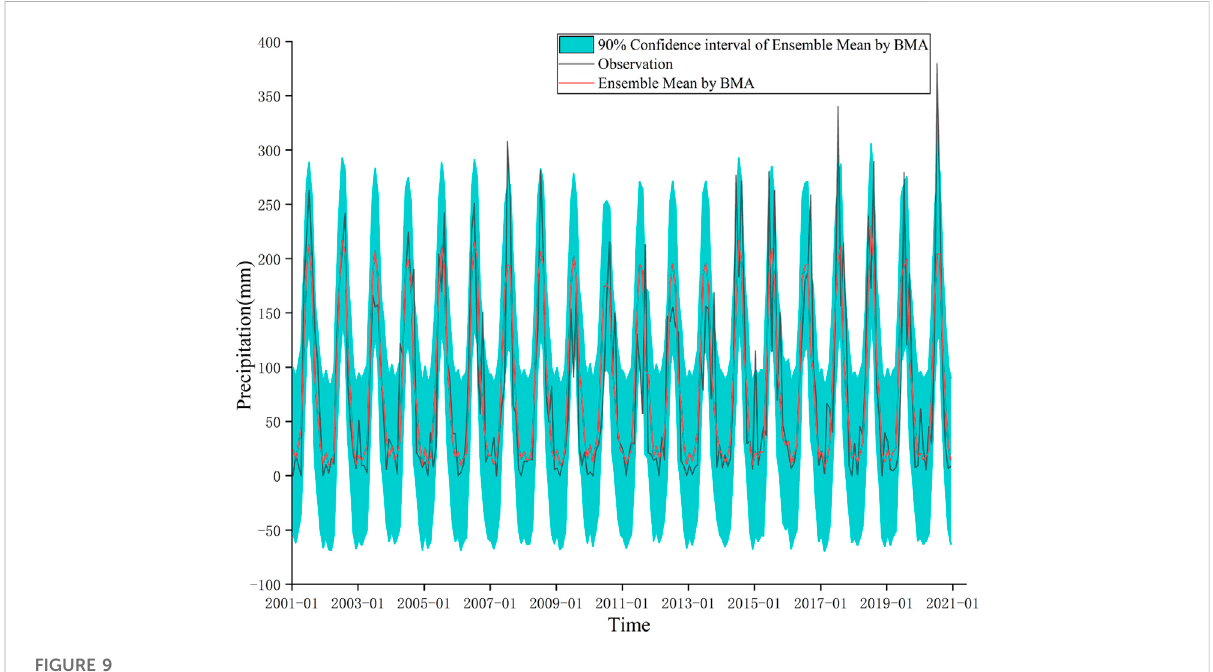
FIGURE 9 Results of BMA with three single models.